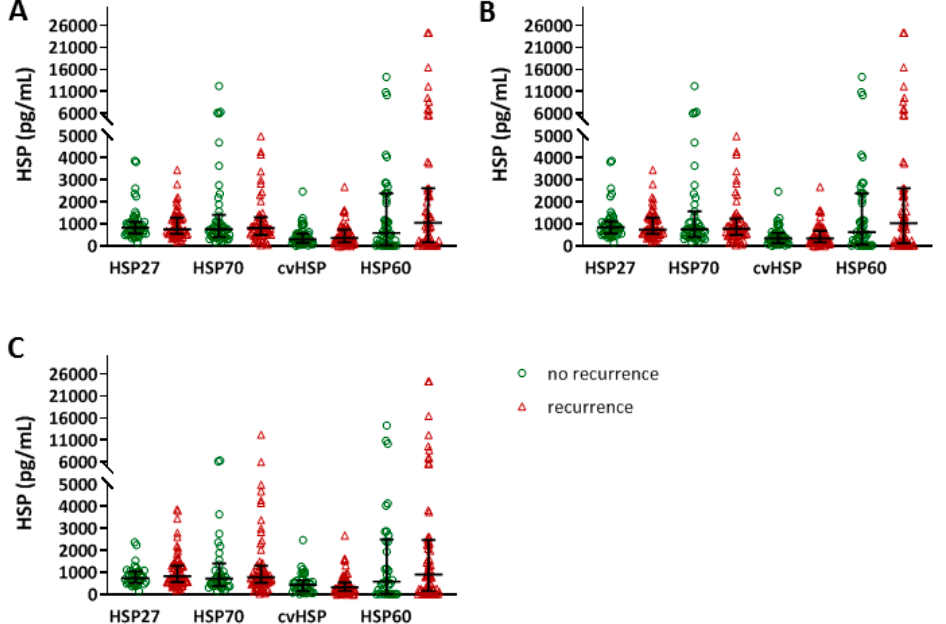
Figure 2. No differences in baseline HSP27, HSP70, cvHSP or HSP60 serum levels between patients with and without AF recurrence after electro cardioversion (ECV). HSP27, HSP70, cvHSP and HSP60 serum levels (pg/mL) at baseline, comparing patients with and without AF recurrence within 3 months ( A ), 6 months ( B ) and 1 year ( C ) after ECV treatment.